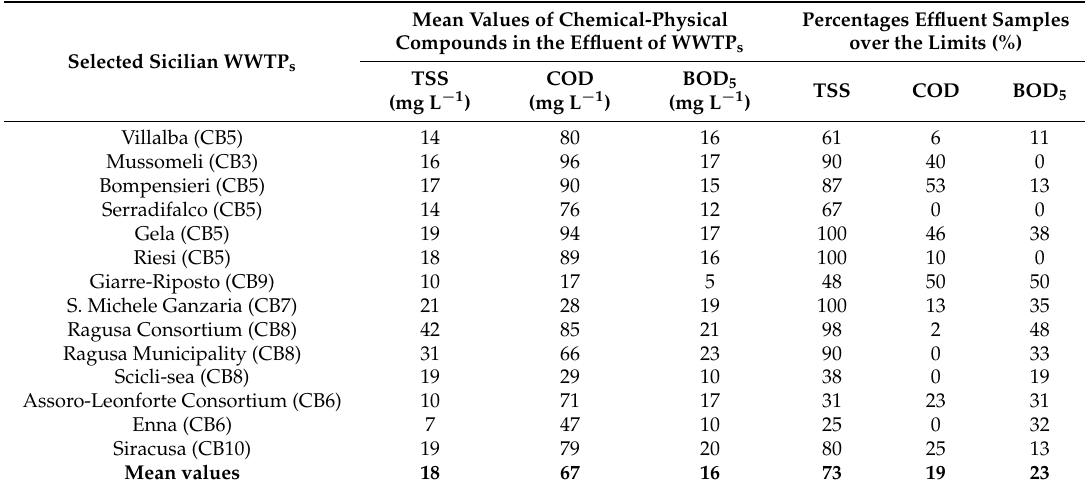
Table 3. Chemical-physical characteristics of selected WWTP s in